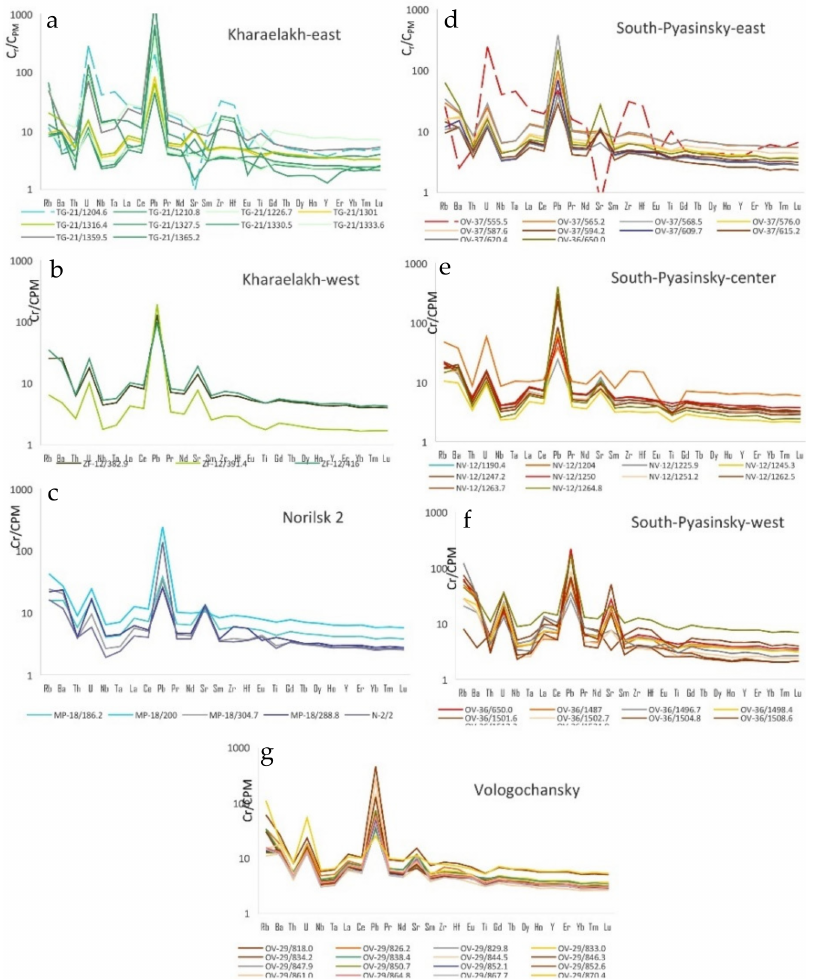
Figure 9. Spider diagrams for the rocks of the Norilsk area: ( a ) Kharaelakh, TG-21 (East); ( b ) Kharaelakh, ZF-12 (West); ( c ) Norilsk 2, MP-18; ( d ) South Pyasinsky, OV-37 (East); ( e ) South Pyasinsky, NV-12 (Center); ( f ) South Pyasinsky, OV-36 (West); and ( g ) Vologochansky, OV-29. Normalized to the primitive mantle after